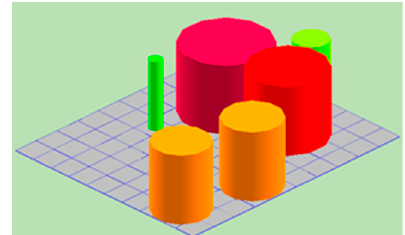
Figure 2. A 3D model of chloride concentration distribution on the six